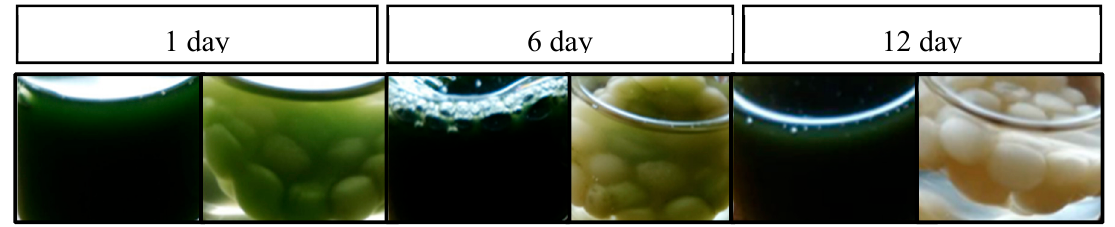
Figure 2. Free (left) and immobilised Nannochloropsis sp. cells (right) grown in f/2 medium and in the presence of PAR, IBU, SIM and OLA, for the indicated periods.